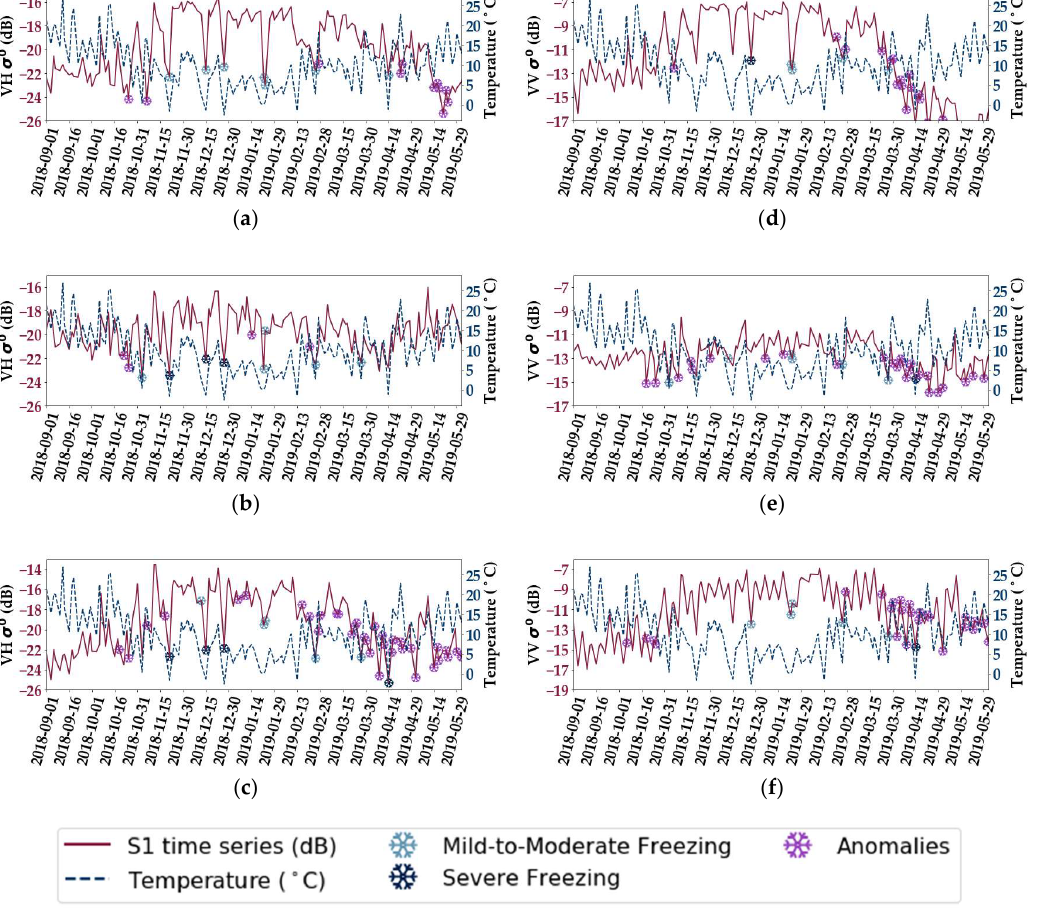
Figure 7. Freezing detection over one reference plot by land cover class in site A, for each S1 acquisition date, using VH and VV polarizations. ( a ) VH-LC1, ( b ) VH-LC2, ( c ) VH-LC3, ( d ) VV-LC1, ( e ) VV-LC2, ( f ) VV-LC3.